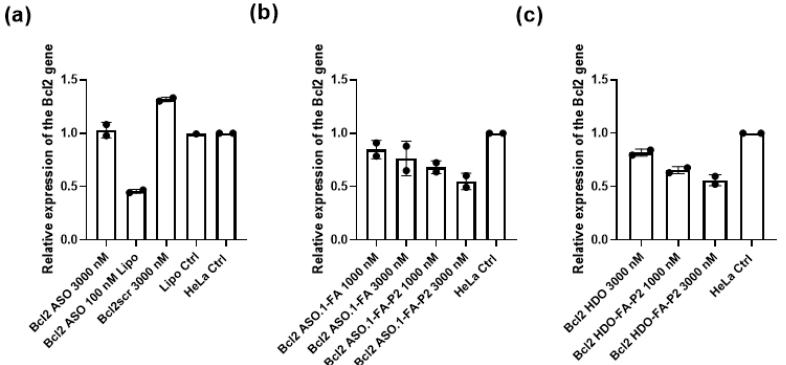
Figure 4. Normalized Bcl2 gene expression in HeLa cells 48 h after transfection ( a ) with, ( b,c ) without lipofectamine (Lipo)). HDO is heteroduplex oligonucleotide, FA is folic acid and P2 is peptide 2. Lipo Ctrl is the control experiment where we treated the cells with lipofectamine solution without oligonucleotide added. The data were normalized using the GAPDH and the YWHAZ genes as reference genes. Error bars indicate standard deviation (SD) of at least two independent biological replicates.